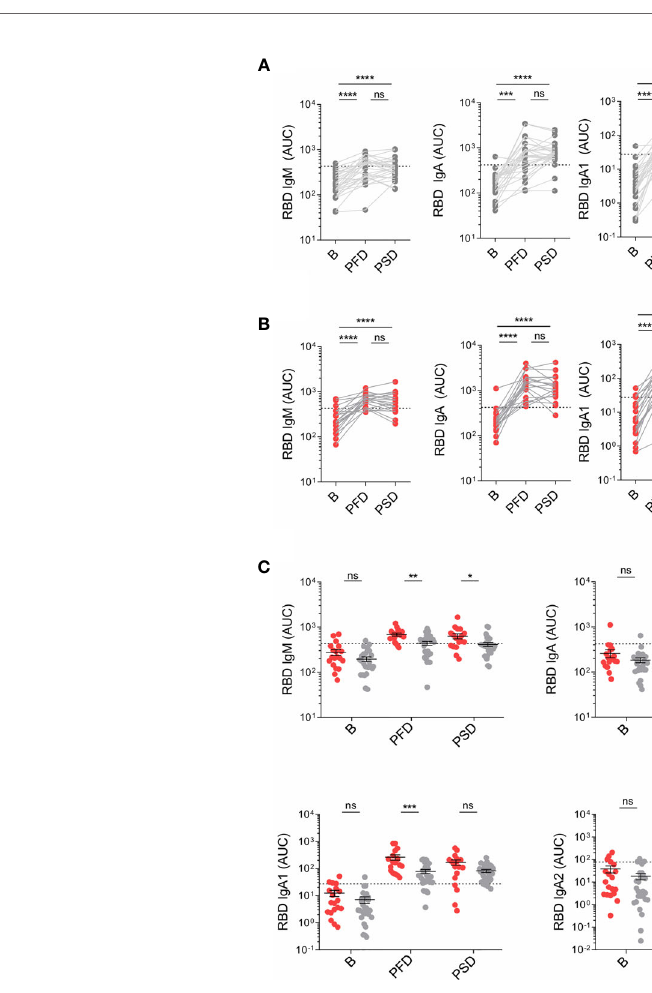
FIGURE 2 | mRNA-1273 primary immunization triggers increased levels of WT RBD-speci fi c IgM, IgA and IgA subclasses in recovered individuals compared to SARS-CoV-2 naïve individuals. (A) Area under the curve (AUC) for each of the WT RBD-speci fi c IgM, IgA and IgA subclasses analyzed from SARS-CoV-2 naïve individuals overtime. (B) AUC for each of the WT RBD-speci fi c IgM, IgA, and IgA subclasses analyzed from SARS-CoV-2 recovered individuals overtime. (C) AUC for each of the WT RBD-speci fi c IgM, IgA and IgA subclasses analyzed from SARS-CoV-2 naïve and recovered individuals overtime depicted in the same graph. Sera from SARS-CoV-2 naïve individuals at baseline were used to establish negative threshold values de fi ned as the naïve AUC mean plus 2 times the standard deviation of the mean. Bars represent mean ± standard error mean (SEM). Dashed line indicates negative threshold. Data are presented as individual dots. Wilcoxon matched pairs test was performed to compare time points. Two-tailed Mann-Whitney U test was performed to compare SARS-CoV-2 naïve and recovered individuals (ns, not signi fi cant P > 0.05, *P < 0.05, **P < 0.01, ***P < 0.001, and **** P< 0.0001). SARS-CoV-2 naïve, n=27; SARS CoV-2 recovered,